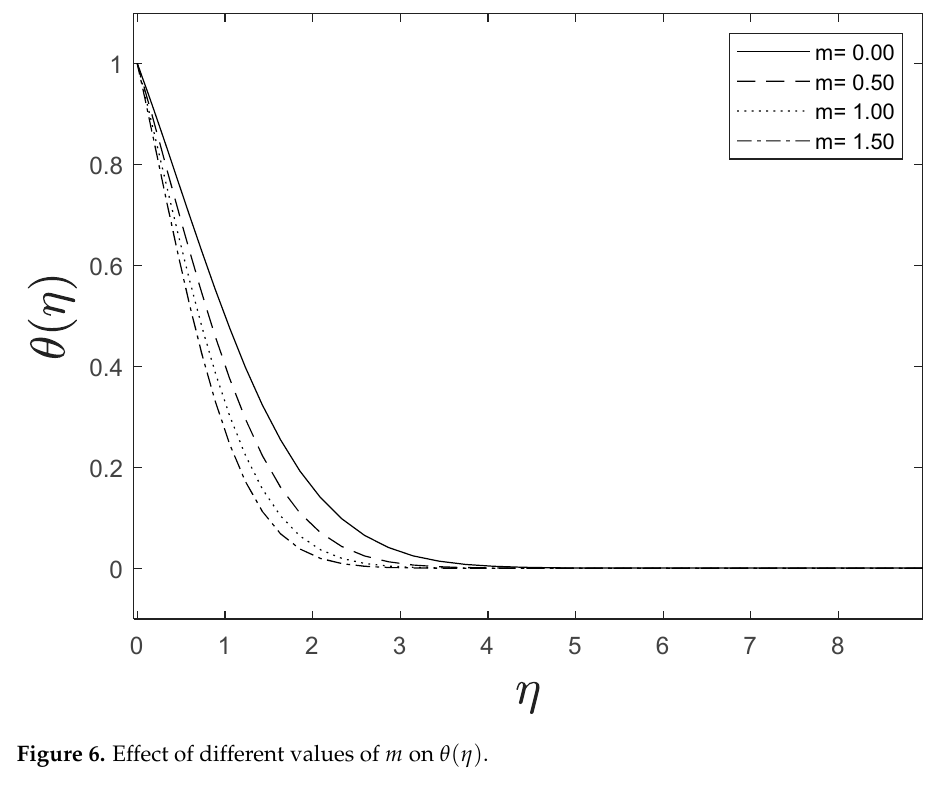
Figure 6. Effect of different values of m on θ ( η ) .